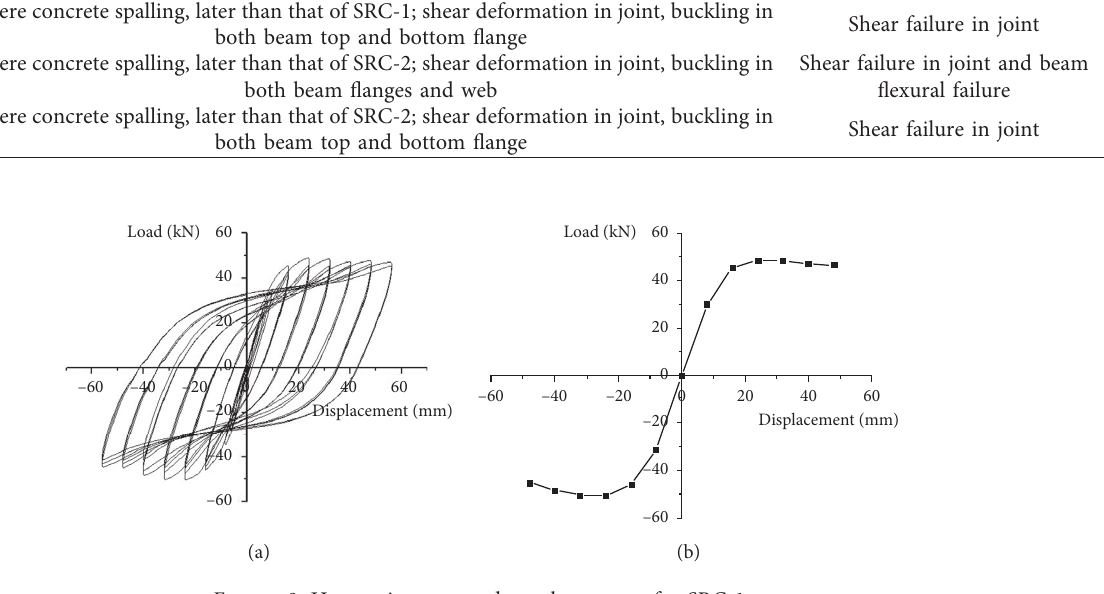
Figure 9: Hysteretic curve and envelope curve for